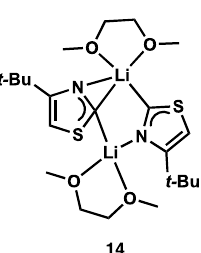
Figure 3. Lithiated 4- tert -butylthiazole 14 featuring C/N metalation.